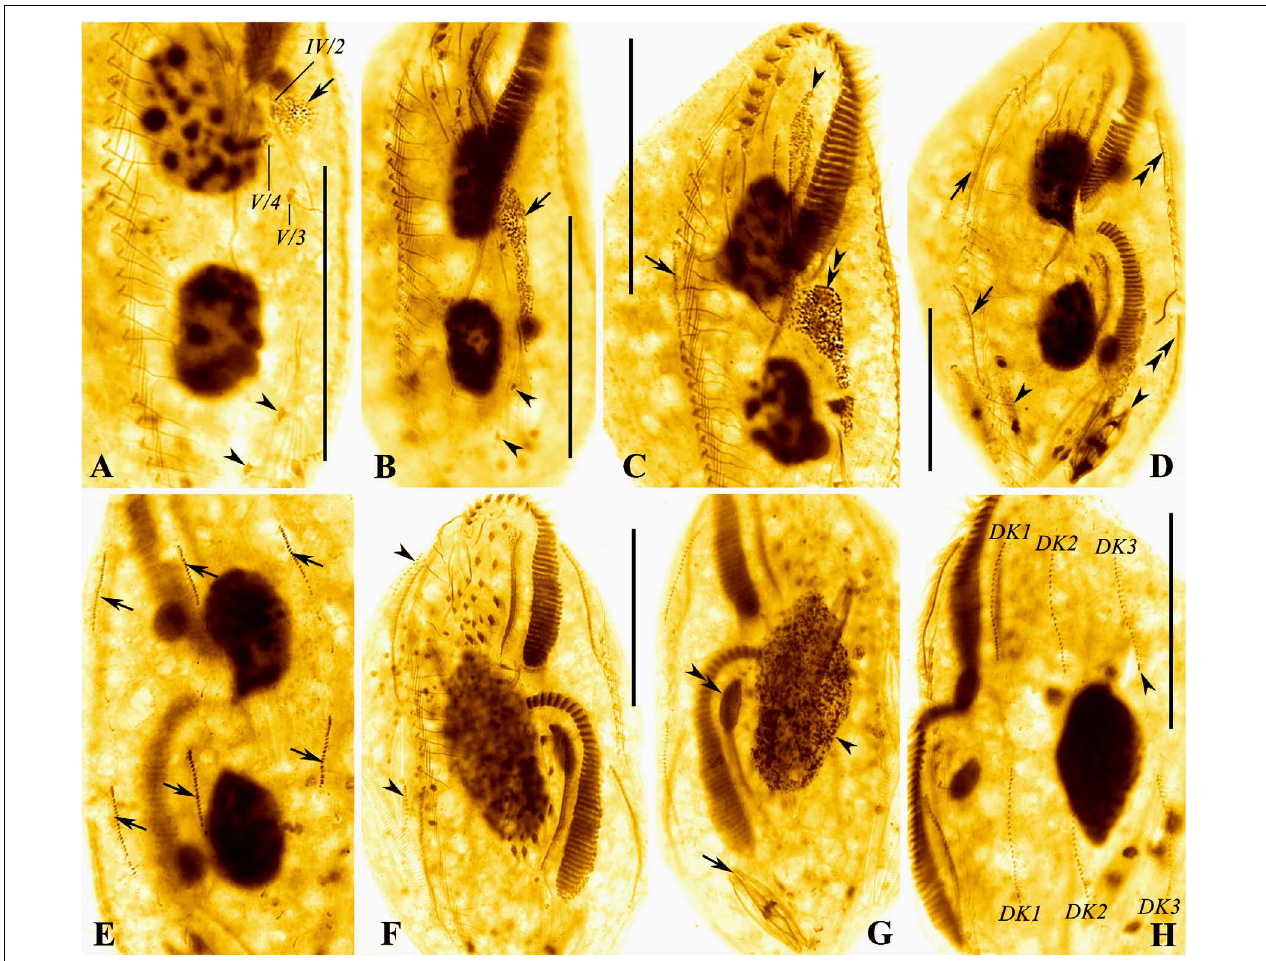
FIGURE 6 | (A–H) Photomicrographs of the Wuhan population of Rubrioxytricha haematoplasma during the ontogenetic process after protargol impregnation. (A,B) Ventral views of very early dividers, showing the formation of oral primordium (arrows); arrowheads indicate pretransverse ventral cirri. (C) Ventral view of an early divider, showing undulating membranes anlage of proter (= anlage I, arrowhead) dedifferentiated from the old structure, right marginal anlage of proter (arrow), and newly formed adoral membranelles of the opisthe (double arrowheads). (D,E) Ventral (D) and dorsal (E) views of a middle divider, showing right marginal anlagen (arrows in D ), left marginal anlagen (double arrowheads), and dorsal kinety anlagen (arrows in E ); arrowheads mark diatoms in the cell. (F,G) Ventral (F) and dorsal (G) views of a late divider, showing dorsomarginal kinety anlagen (arrowheads) formed near anterior ends of right marginal anlagen, fused macronuclear mass (arrowhead) and micronucleus (double arrowheads); arrow marks diatoms in the cell. (H) Ventral view of a late divider, showing newly formed dorsal kineties and new caudal cirrus (arrowhead) formed at the end of dorsal kinety 3. DK1–3, new dorsal kineties. Scale bars = 50 µ